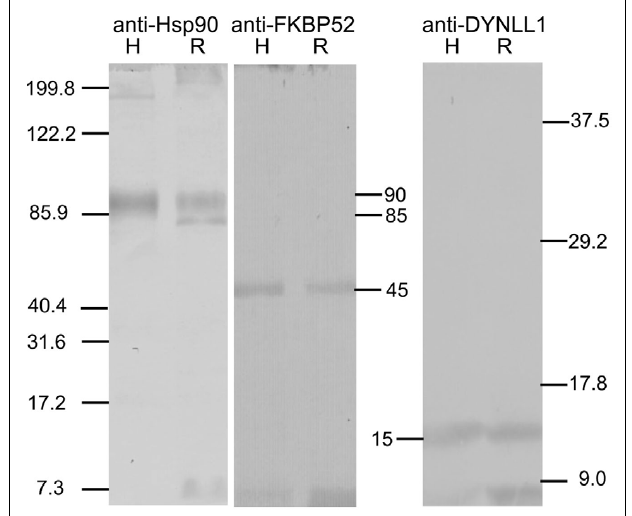
FIGURE 1 |Western blots showing immunoreactivity of control human proteins Hsp90, FKBP52 and DYNLL1 (lanes labeled H), and proteins extracted from Rhodnius SG cells (lanes labeled R) to anti-Hsp90 (left panel), anti-FKBP52 (middle panel), and anti-DYNLL1 (right panel) respectively. The standards are shown on left and right.The relative molecular sizes of the proteins recognized by these antibodies are shown in the middle.Two proteins approximately at 90 and 85kDa immunoreact with the anti-Hsp90 in SG cell extracts; the 90-kDa protein co-migrates with the 90-kDa control Hsp90. A Rhodnius protein at approximately 45kDa immunoreacts with anti-FKBP52 and co-migrates with the control FKBP52 protein. A Rhodnius protein at approximately 15kDa immunoreacts with anti-DYNLL1 and co-migrates with the control DYNLL1